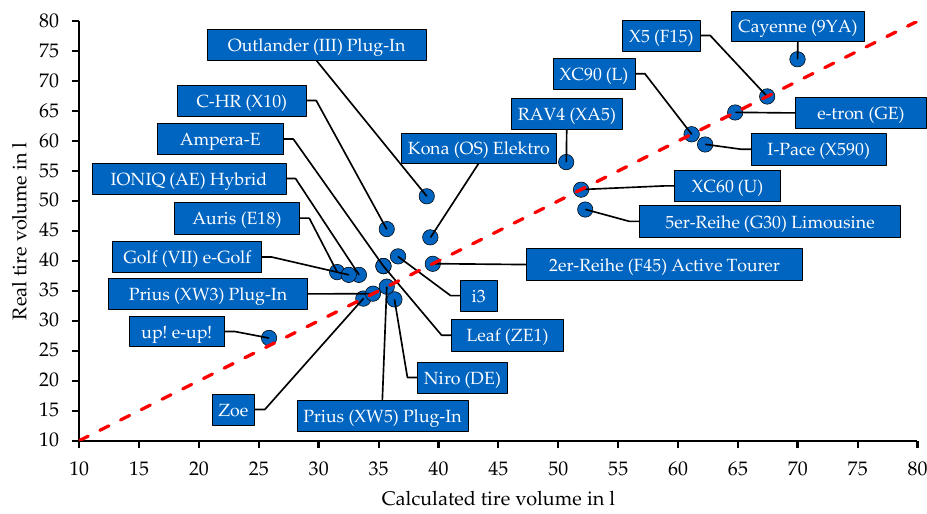
Figure 4. Whole-model plot for the tire-volume evaluation.